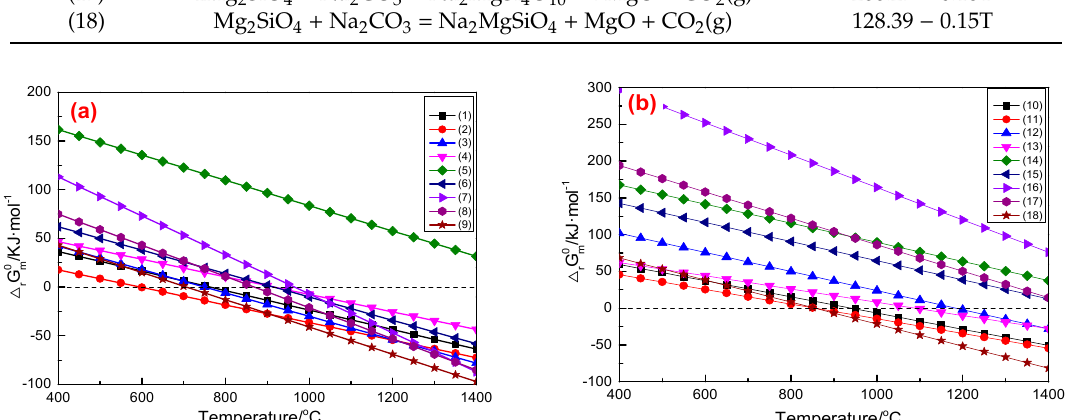
Figure 4. Plots of Gibbs free energy against the temperature of ( a ) Na 2 CO 3 -MgSiO 3 and ( b ) Na 2 CO 3 -Mg 2 SiO 4.